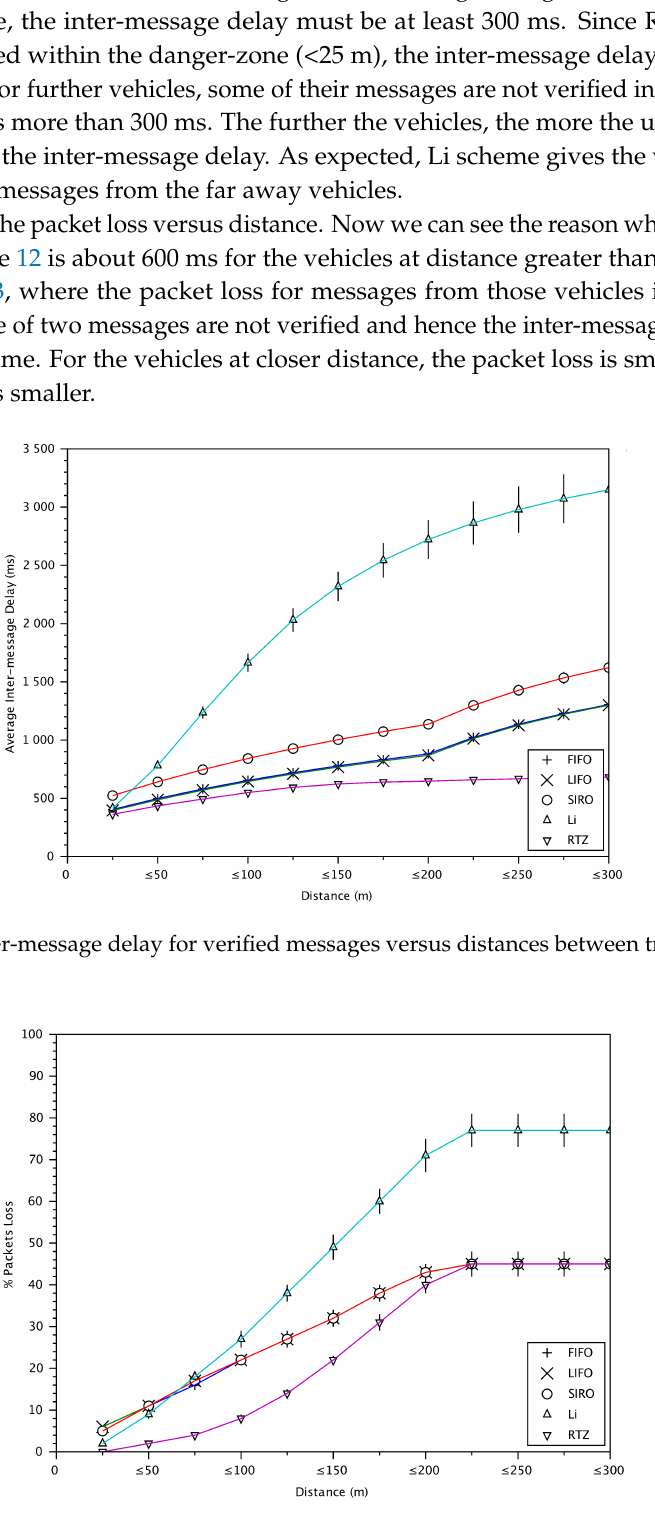
Figure 13. The cumulative percentage of packet loss with respect to distances between